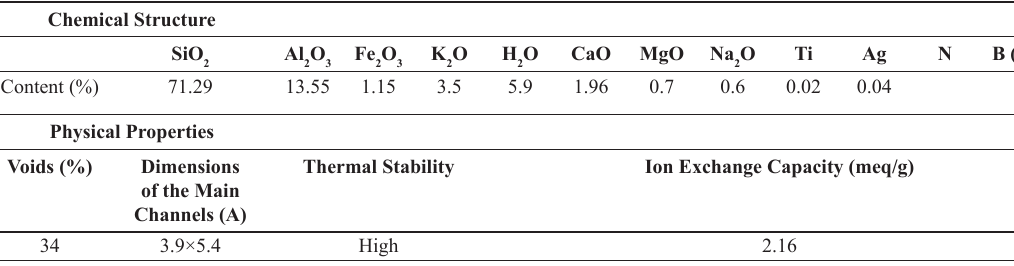
Table 4. Physical properties and chemical structure of natural